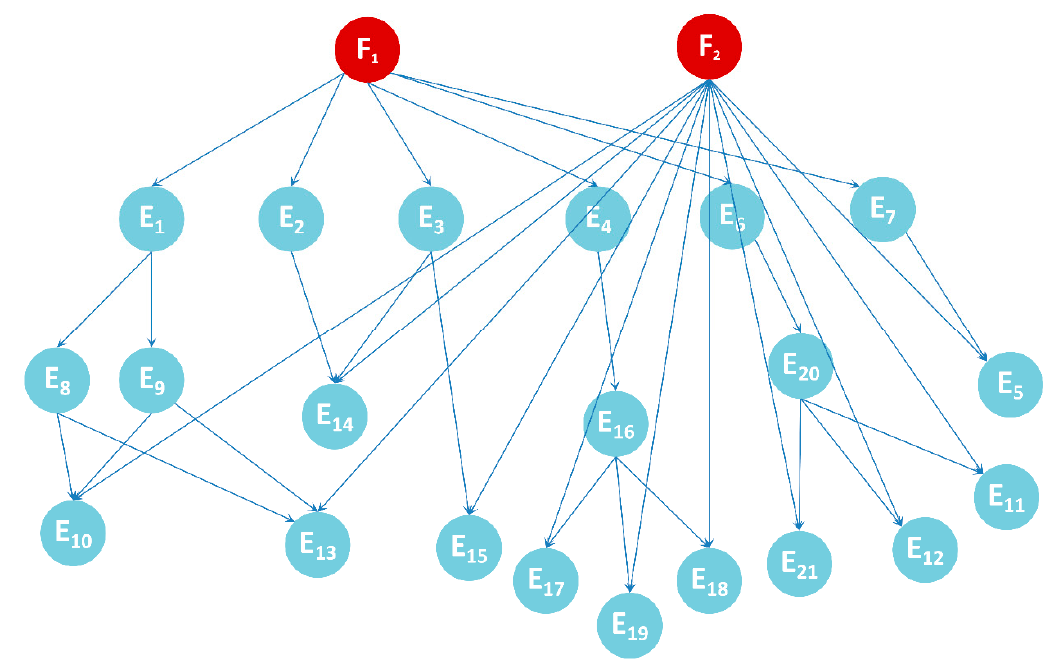
Figure 6. Bayesian network model.